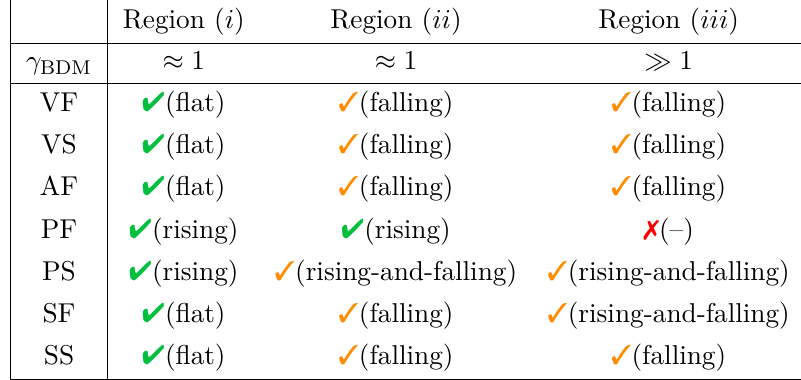
Table 2 . A summary of our case studies. Conditions of each region are defined in eq. (4.1). γ BDM denotes the Lorentz boost factor of BDM. 4 and 3 indicate that one can find mass spectra to reproduce the XENON1T excess and satisfy the conditions of the associated regions, while for entries marked with 3 a certain range of mediator mass may not reproduce the XENON1T excess. By contrast, 7 indicates that it is generally hard to find a mass spectrum to explain the